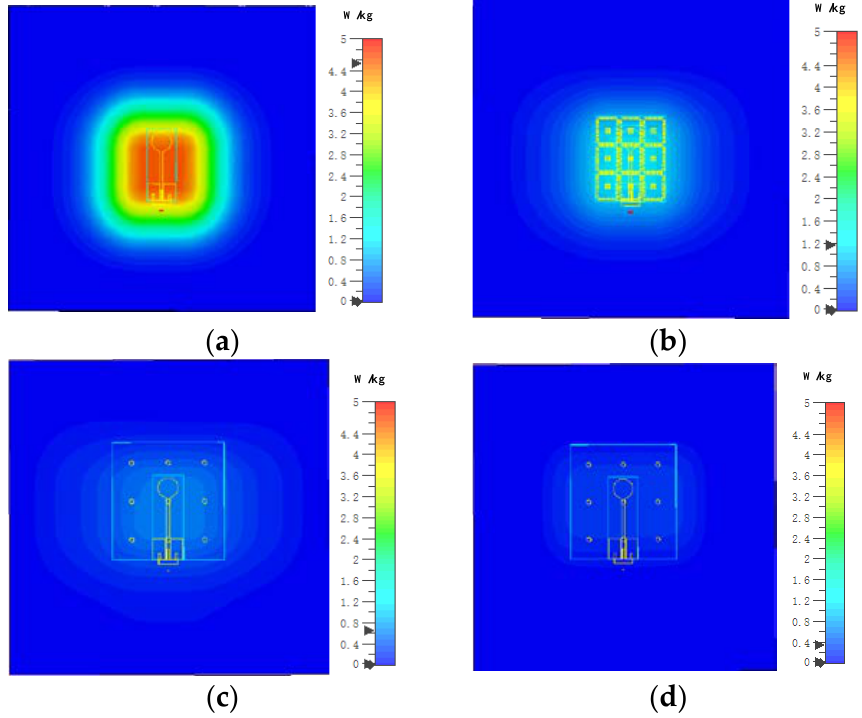
Figure 9. Simulated Specific Absorption Rate (SAR) of the metasurface antenna over the human body. ( a ) The feeding structure without metasurface at 2.65 GHz. ( b ) The feeding structure with metasurface at 2.65 GHz. ( c ) The dual band antenna at 2.5 GHz. ( d ) The dual band antenna at 3.65 GHz [5].